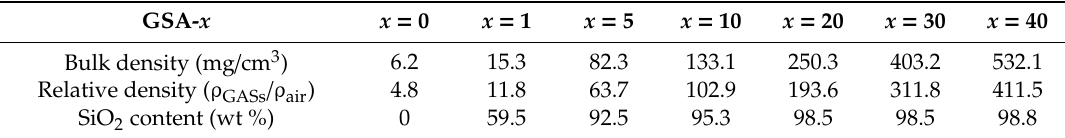
Figure 4. Investigation of GSA thermal-insulation properties. ( a ) Relationship between bulk density versus concentration of perfusion SiO 2 sol. ( b , c ) Effects of surrounding temperature (300–460 K) and bulk density on thermal conductivity, respectively. ( d – f ) Linearly fitting results for thermal conductivity as a function of surrounding temperature for GSA- x ( x = 0, 20, and 40, respectively). Table 1. Bulk density, relative density, and SiO 2 content of GSAs.